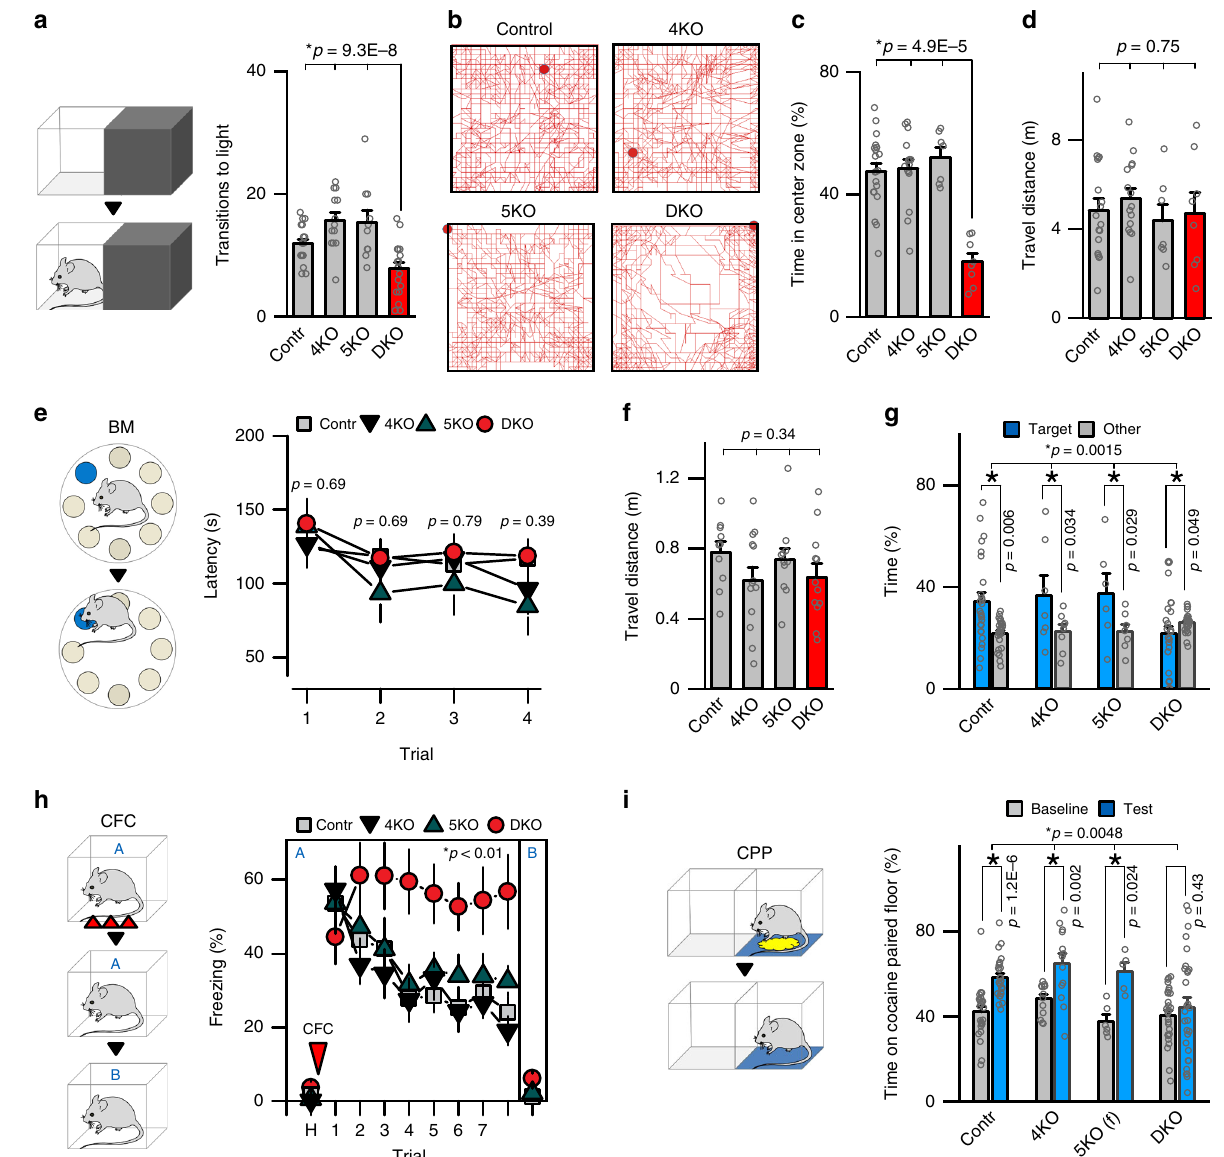
Fig. 3 Behavior of class IIa HDAC-de fi cient mice. Animals of indicated genotypes were examined at p60. See also Supplementary Fig. 7 and Methods. a Analysis of anxiety-like behavior in the dark – light transfer test. Schematics of experimental setup and averaged transitions to light are shown. Control: n = 19 mice; 4KO: n = 13; 5KO: n = 10; DKO: n = 19. b – d Locomotor activity in the open fi eld setup. b Typical tracks during 30 min sessions. c Averaged times spent in the center zone. d Total travel distances. Control: n = 20; 4KO: n = 15; 5KO: n = 7; DKO: n = 8. e – g Assessment of spatial memory in the Barnes maze. e Schematics of the maze and averaged latencies to escape through the tunnel in each of the four sequential daily training sessions. Control: n = 30; 4KO: n = 13; 5KO: n = 10; DKO: n = 30. f Total travel distances in the maze during training. g Memory retrieval in the probe test with escape tunnel removed. Graph shows averaged percentages of time spent in the correct (target) and other quadrants of the maze. Control: n = 30; 4KO: n = 12; 5KO: n = 11; DKO: n = 29. h Acquisition and extinction of associative fear memory. Mice were allowed to habituate (H) and then subjected to CFC in Context A. Freezing was measured on a daily basis in the same or irrelevant context (Context B). Control: n = 15; 4KO: n = 14; 5KO: n = 11; DKO: n = 11. i Conditional place preference (CPP) test. Graph shows averaged times spent on cocaine-paired fl oor. Control: n = 27; 4KO: n = 13; 5KO: n = 6§; DKO: n = 29. All quanti fi cations are represented as Mean ± SEM. * p < 0.05 (de fi ned by t -test and ANOVA). Actual p -values are indicated in each graph (vertical for t -test and horizontal for ANOVA). § No sex-related differences in behavior were observed with exception of HDAC5-de fi cient mice in the CPP test, where only females had preference for cocaine-paired fl